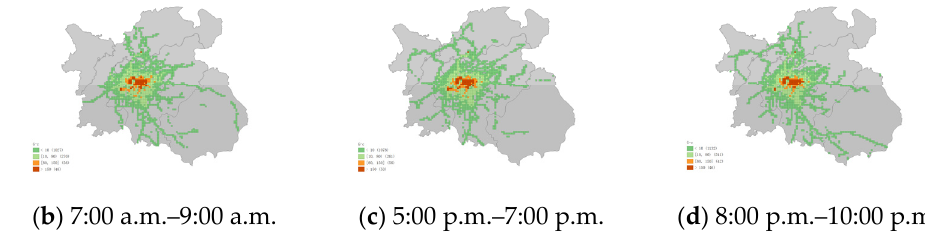
Figure 13. ( a ) Grid carbon emissions (G-c) of each grid area at 1:00 a.m.–3:00 a.m. ( b ) Grid carbon emissions (G-c) of each grid area at 7:00 a.m.–9:00 a.m. ( c ) Grid carbon emissions (G-c) of each grid area at 5:00 p.m.–7:00 p.m. ( d ) Grid carbon emissions (G-c) of each grid area at 8:00 p.m.–10:00 p.m.